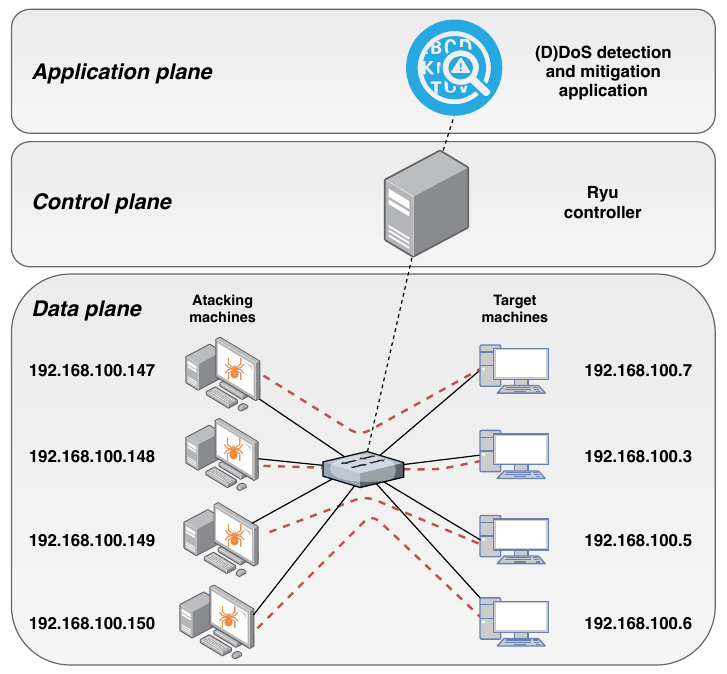
Figure 6. Test bed topology of the second scenario. Adapted from [16].